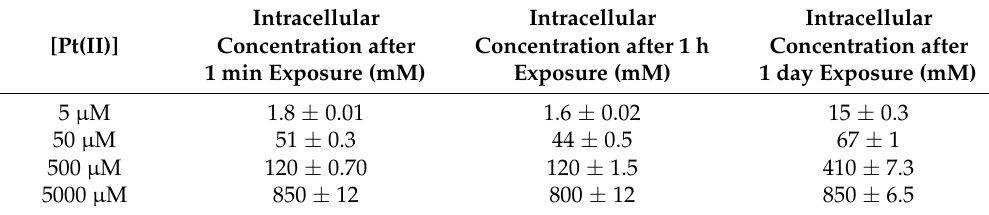
Table 3. Immobilisation study where C. metallidurans was reacted with aqueous Pt(II).